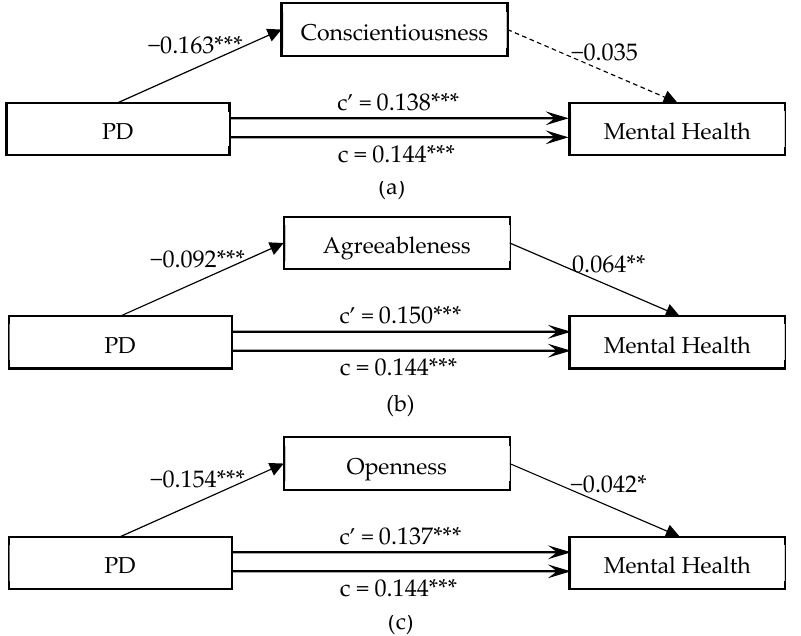
Figure 2. Mediating effect of big five personality dimensions on the associations between PD and mental health. Note: PD denotes total differences for parental parenting styles. * refers to p < 0.05; ** refers to p < 0.01; *** refers to p < 0.001.